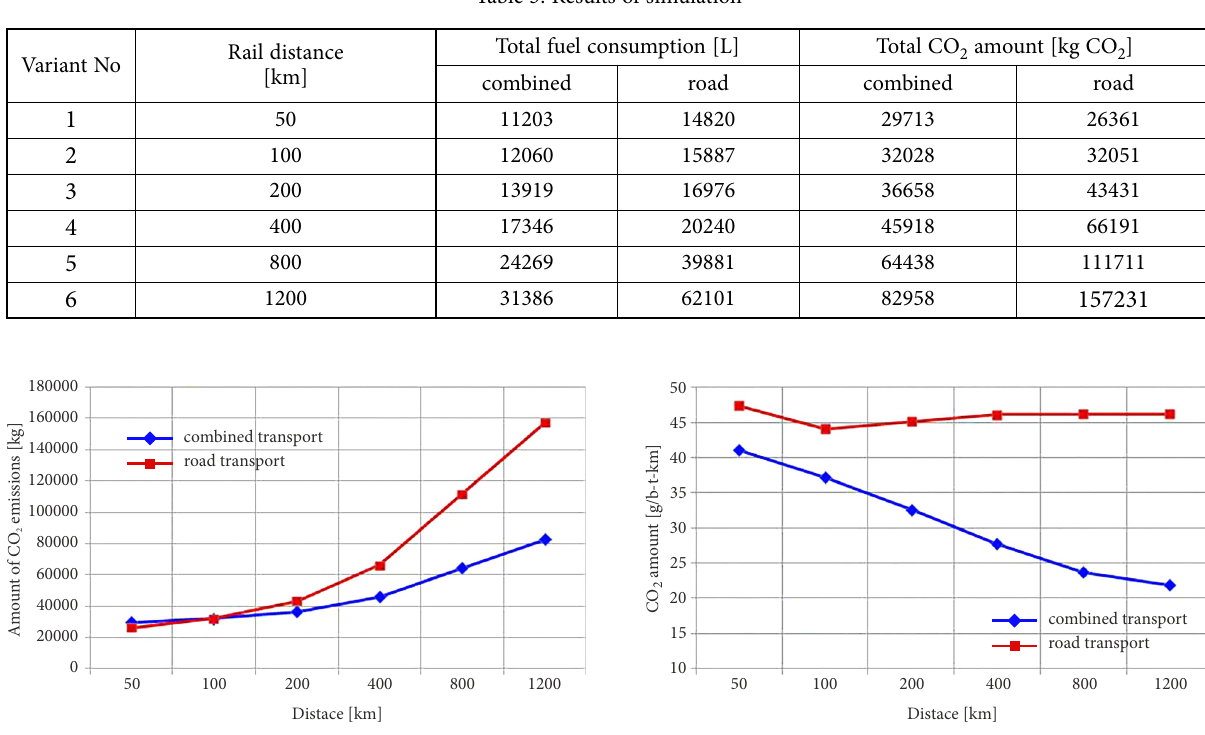
Figure 4. Total CO 2 emission as a function of rail distance and an average CO 2 emission in the road and intermodal transport